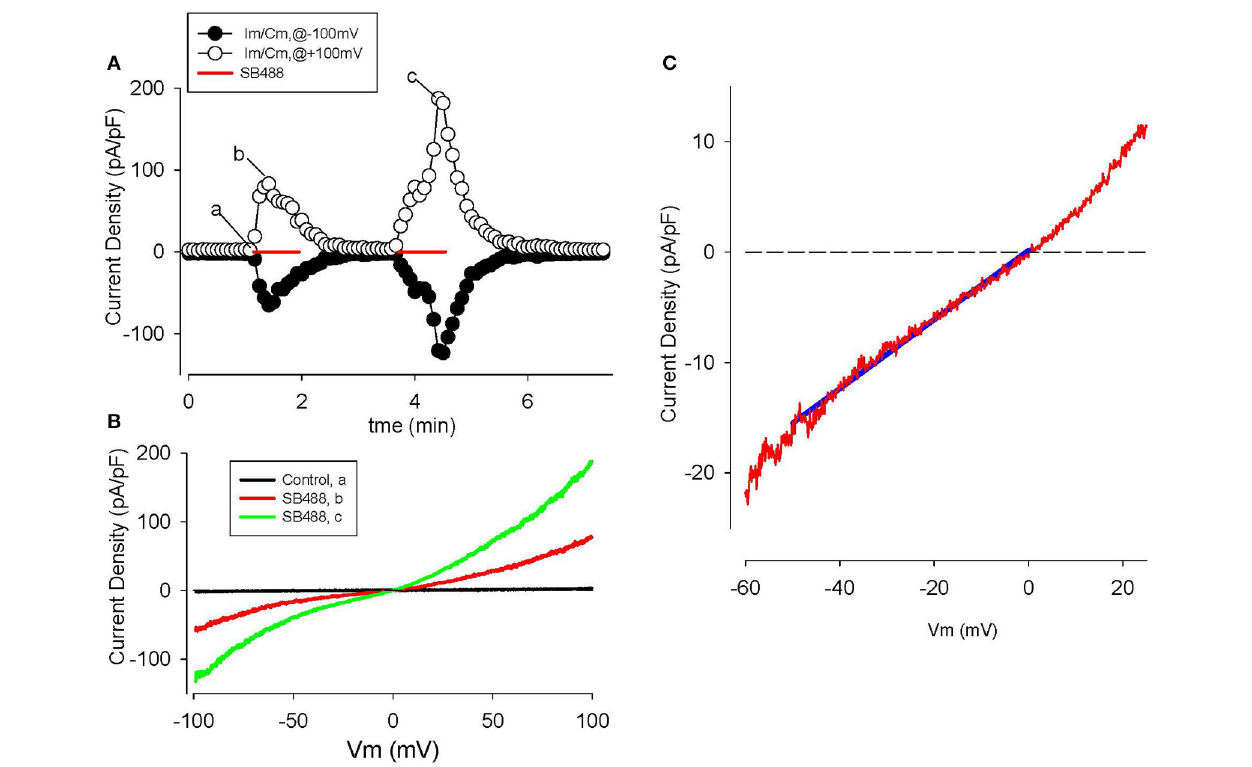
FIGURE 8 | Activation of TRPV4 channel currents by the GSK agonist, SB488, in human articular chondrocytes. (A) Time course of membrane current density changes at 100 (open circles) and 100mV (closed circles) during repeated ramp voltage-clamp protocols. Red bars indicate the application of 1 µ M SB488. (B) + − I–V relations before (trace “a,” black) and during application of SB488 (b,c) as illustrated in (A) . (C) I–V for SB488 induced current on reduced membrane voltage and current scales i.e., in the voltage range of the chondrocyte resting membrane potential. The solid blue line is a linear fit to the I–V over the potential range from 0 to −